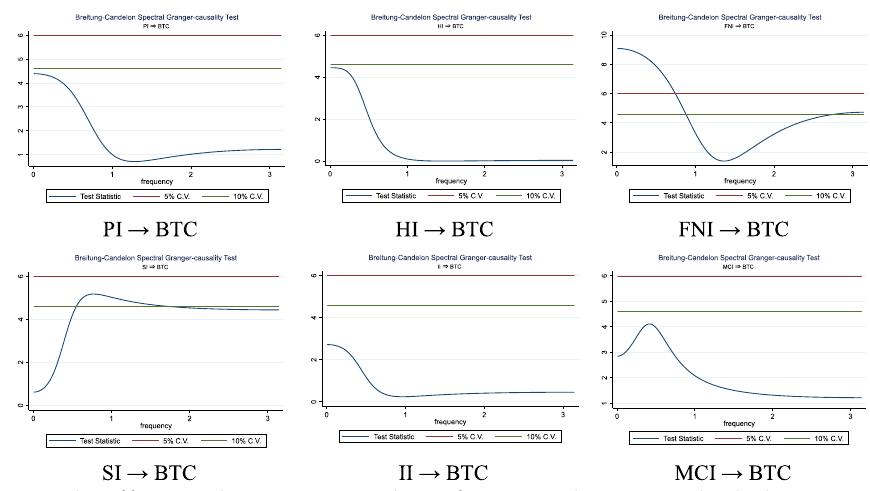
Fig. 7 Plots of frequency domain Granger causality test from RavenPack coronavirus related indices to Bitcoin. Source Authors’ own work. Notes: The incidence of the connection between each RavenPack coronavirus related indices and daily changes of Bitcoin price is investigated at frequencies 2–3, 1–2,